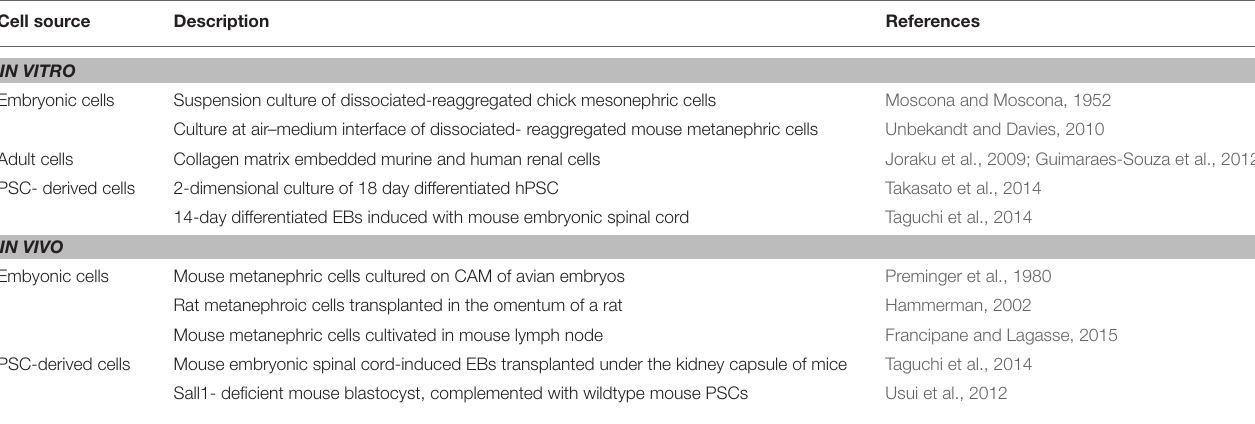
TABLE 1 | Status of lab-grown kidney organoids. Cell source Description